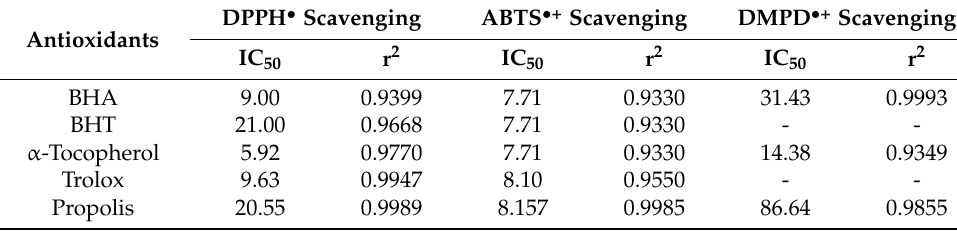
Table 4. The reducing abilities of propolis and standards at concentration of 30 µ